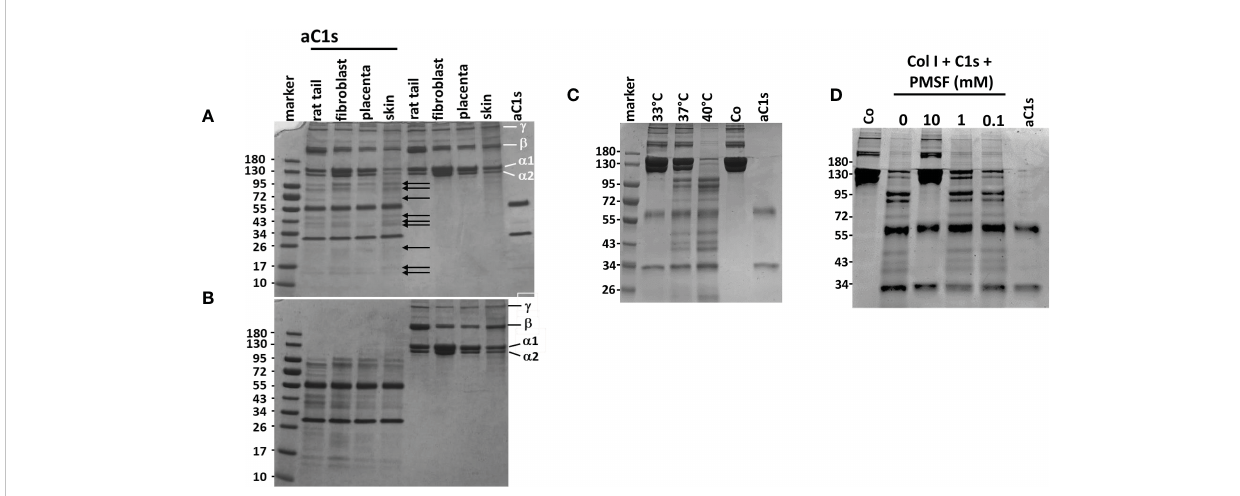
FIGURE 5 Proteolytic activity of aC1s on procollagen I (A) Overnight incubation of collagen I from different sources with aC1s shows partial degradation into different smaller fragments as indicated by arrows. The degradation was independent from the source of collagen I Samples incubated without aC1s remained unaffected, as shown by the a 1, a 2, ß and g collagen I chains. aC1s was represented by two bands, corresponding to the N-terminal chain at approx. 65 kDa and the C-terminal chain at approx. 32 kDa. (B) Denaturation of collagen I prior to incubation with aC1s shows almost complete degradation of procollagen I fi bers into several smaller fragments. Samples incubated without aC1s remain unchanged. (C) C1s-mediated degradation of collagen I is temperature-dependent, with no degradation at an incubation temperature of 33°C, limited degradation at 37°C, and almost complete degradation at 40°C. These data suggest that the collagenase activity of aC1s depends on the unfolded state of collagen I (D) C1s collagenase activity is abolished by addition of the serine protease inhibitor PMSF at 10mM concentration, but lower PMSF concentrations have no inhibitory effect. The data are representative of fi ve independent experiments.